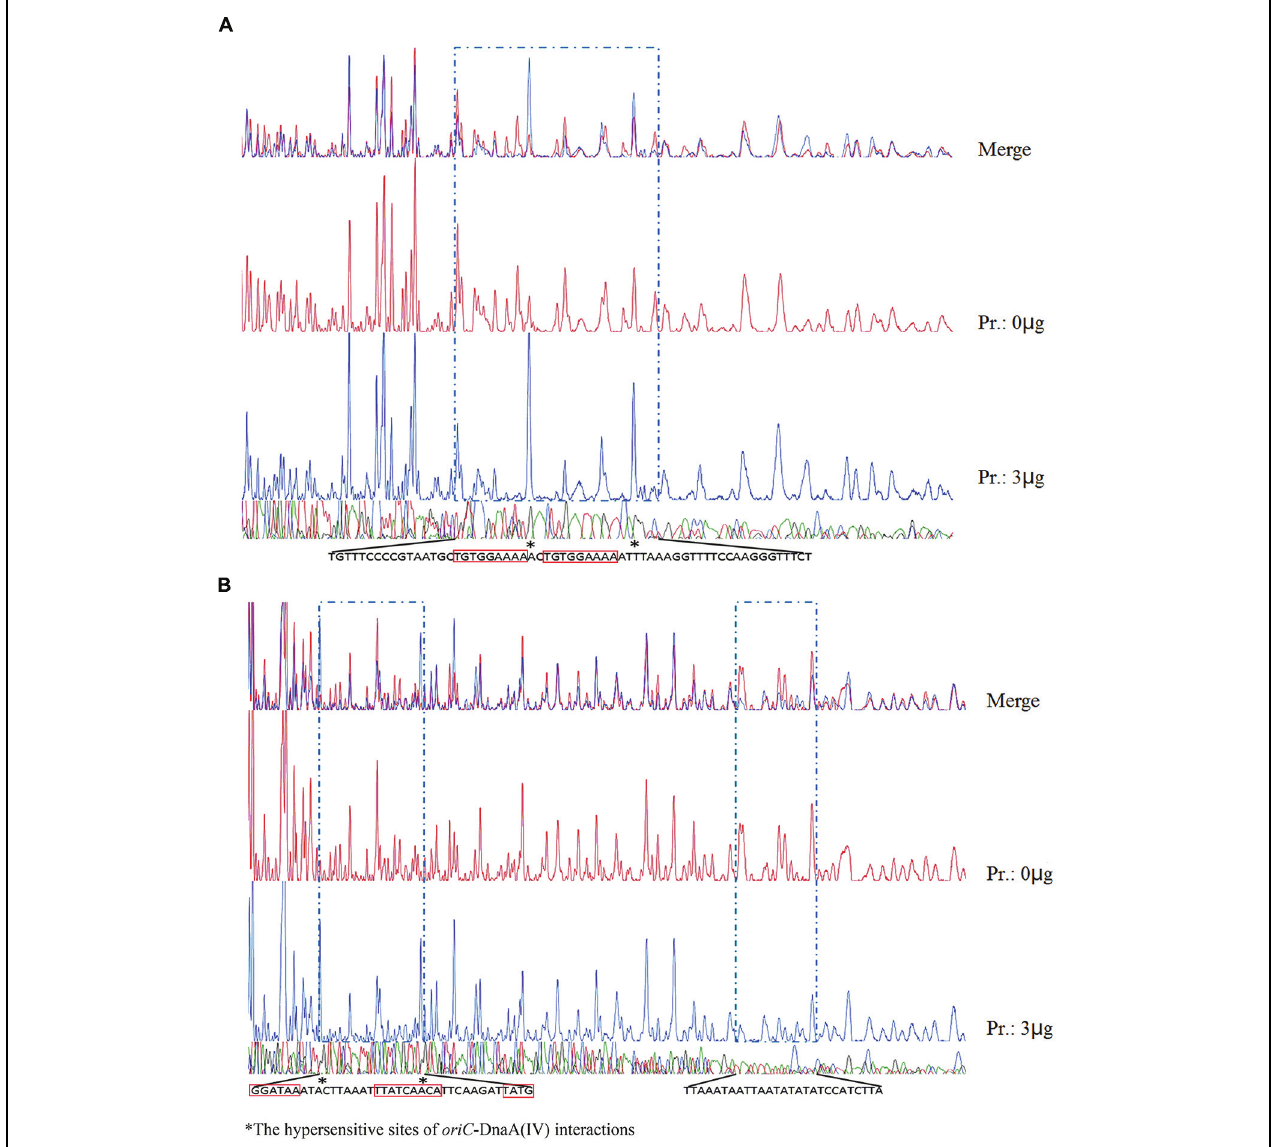
FIGURE 7 | DNase I footprint of protein His 6 -DnaA (IV) to the oriC s of the circular and linear chromosomes. (A) Along with the increase of His 6 -DnaA (IV), a clearly protected region of 39 nt relative to the second and third DnaA boxes sites in the oriC region of the circular chromosome was found, although the first DnaA box was not bound to the protein [the sequences in (A) are reverse complementary]. The asterisks mark the hypersensitive sites, which are consistent with the locations of two DnaA boxes of the circular chromosome. (B) Within the protected regions of the linear chromosome oriC , the results from the DNase I footprinting assay revealed that His 6 -DnaA (IV) protected two specific regions- an AT-rich region, as well as a region containing two DnaA boxes and an incomplete DnaA box (TATG) [the sequences in (B) are reverse complementary]. The asterisks mark the hypersensitive sites, which are consistent with the locations of two DnaA boxes of the linear